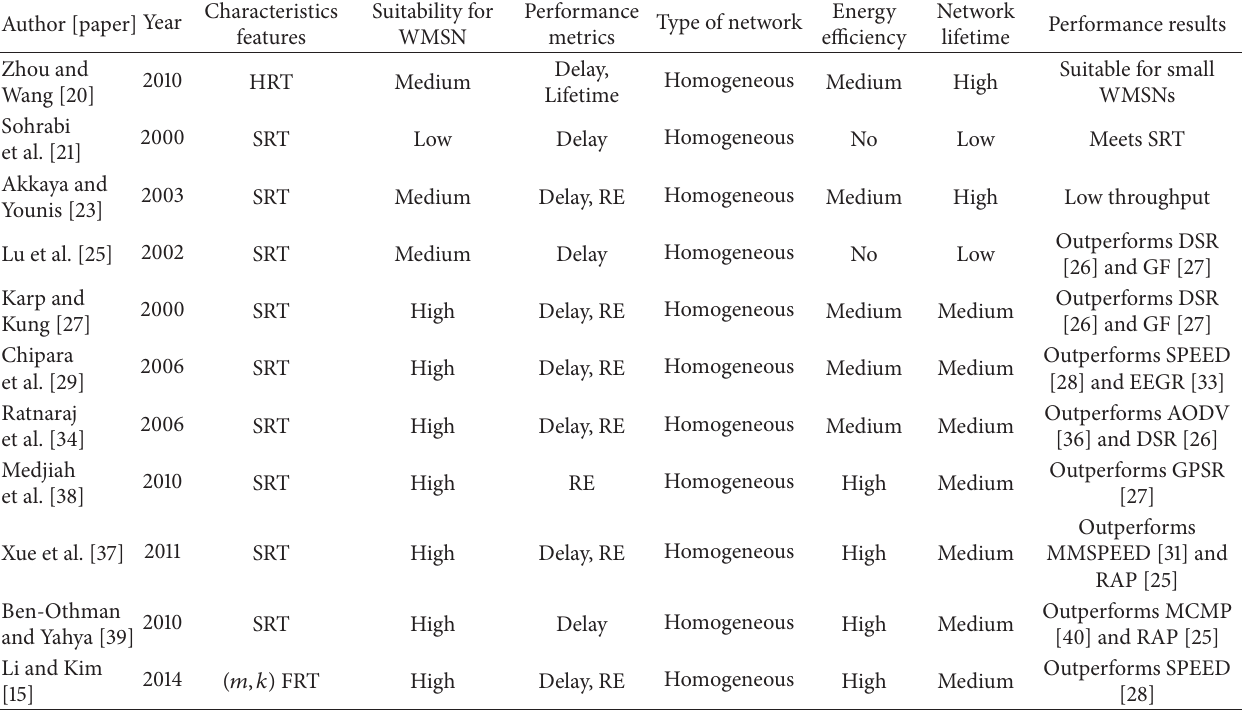
Table 2: Latency based routing